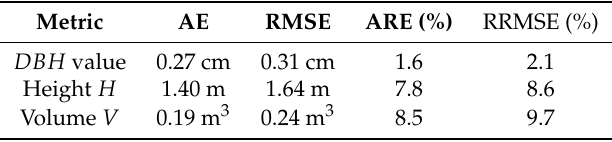
Table 5. Error evaluation for different estimated